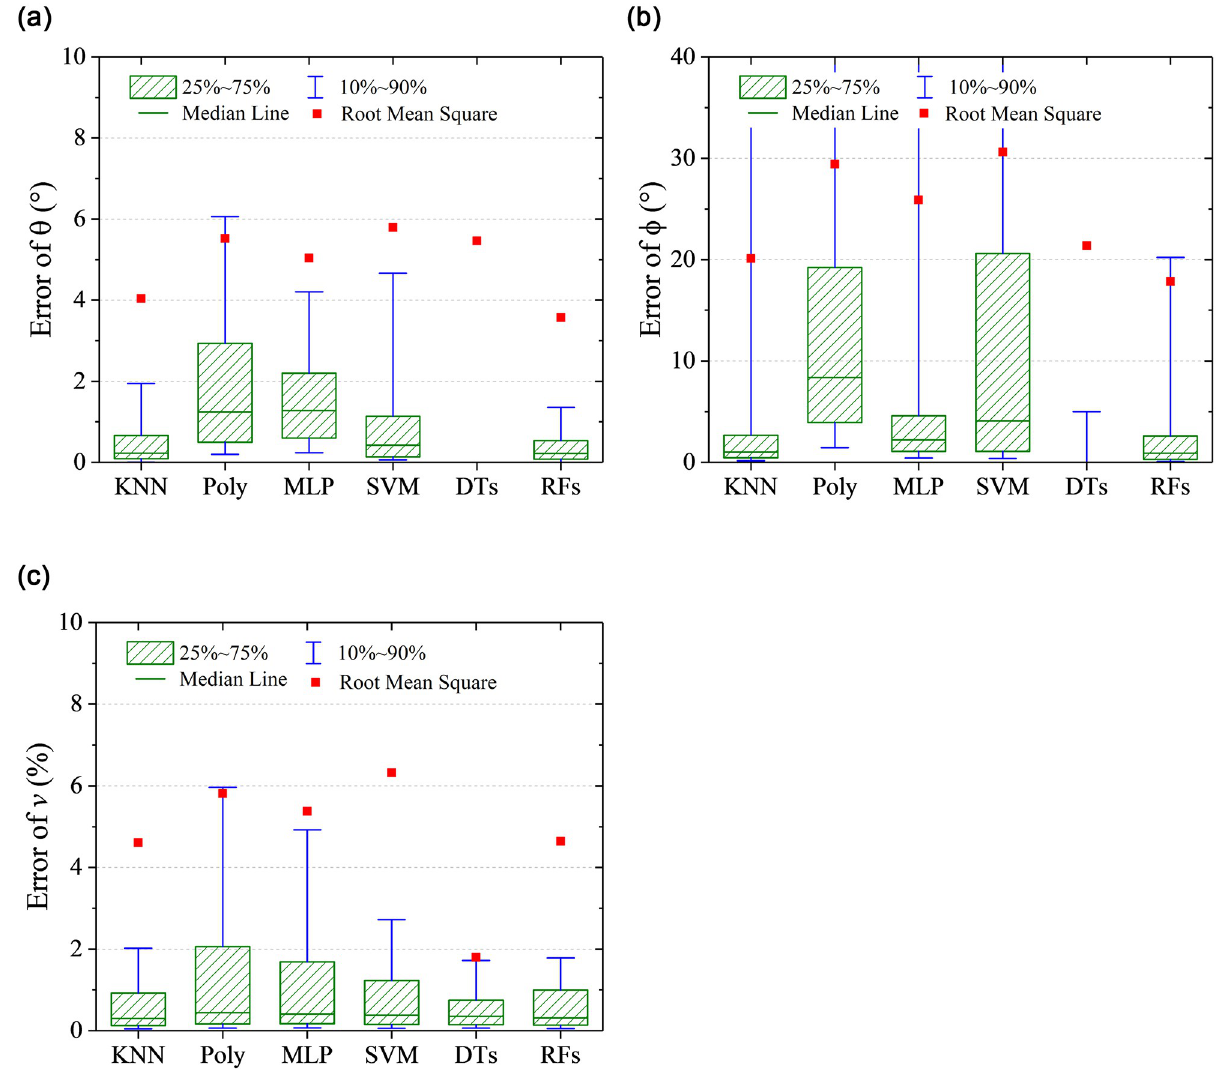
Fig 17. Quantile statistics on the prediction errors. (a) pitching angle, θ , (b) rolling angle, ϕ , (c) flow velocity, v .